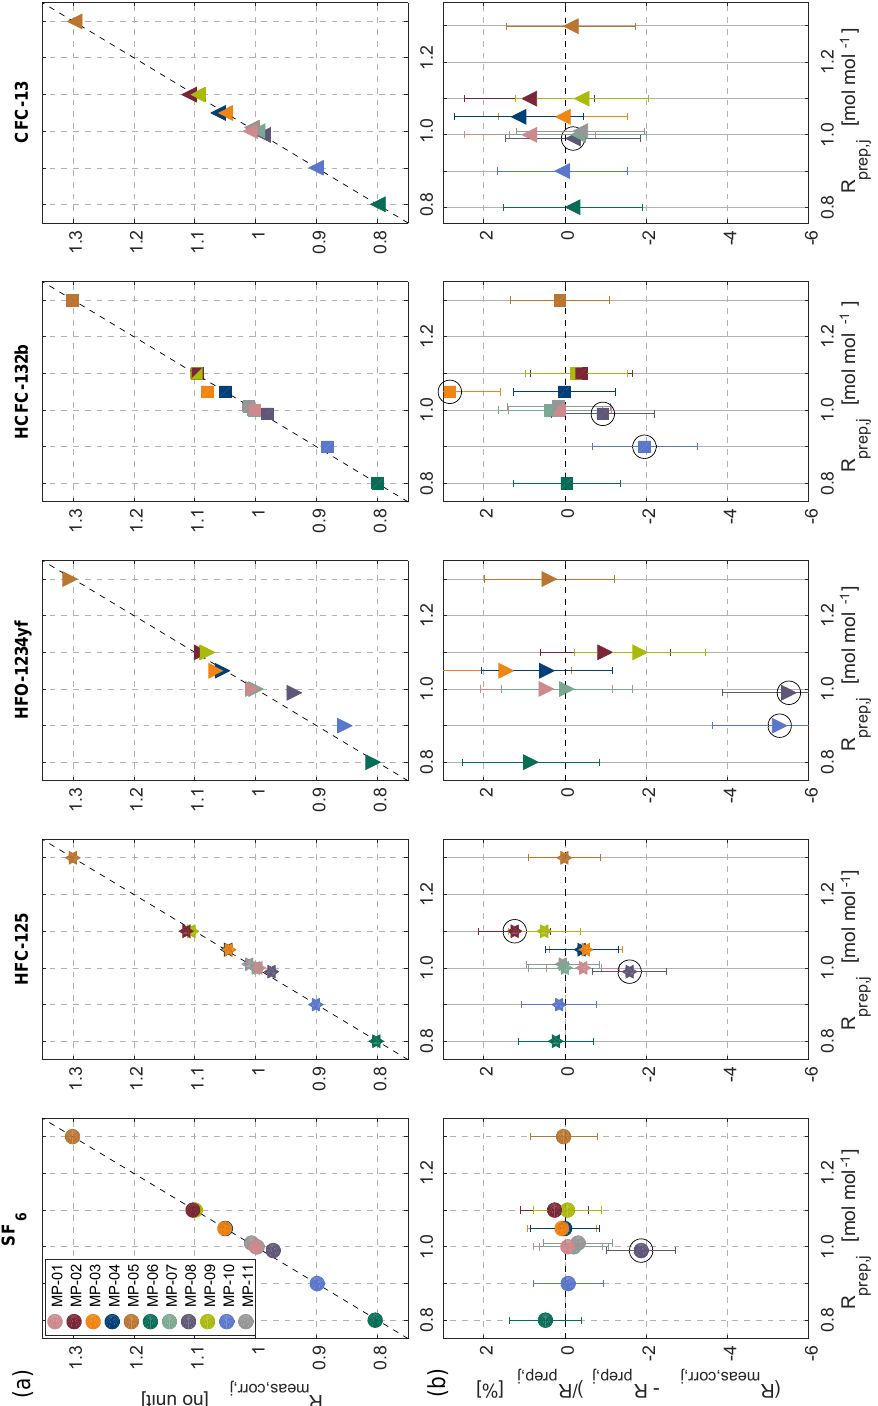
Figure 4. Internal consistency estimates for the METAS-2017 primary calibration scales. (a) Measured ratios R meas , corr ,i,j vs. prepared ratios R prep ,i,j . R prep ,i,j represents the prepared molar fraction in cylinder j divided by the corresponding prepared molar fraction in cylinder MP-001 (Eq. 9). The unit of R prep ,i,j is therefore molmol − 1 . R meas , corr ,i,j is a signal ratio and unit-less. (b) Difference, in percent, between prepared and measured ratios. The error bars take into account the uncertainty of R prep ,i,j as well as the measurement standard deviation of the mean and represent a 95% confidence interval. Outliers excluded from the calculation of the analyser response function are highlighted by black open